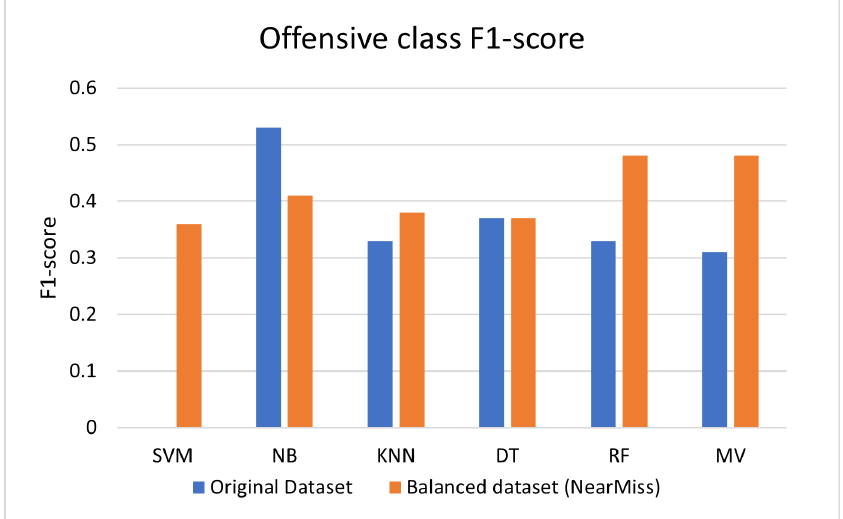
Figure 6. Offensive class F 1 -scores for original and balanced dataset (Near